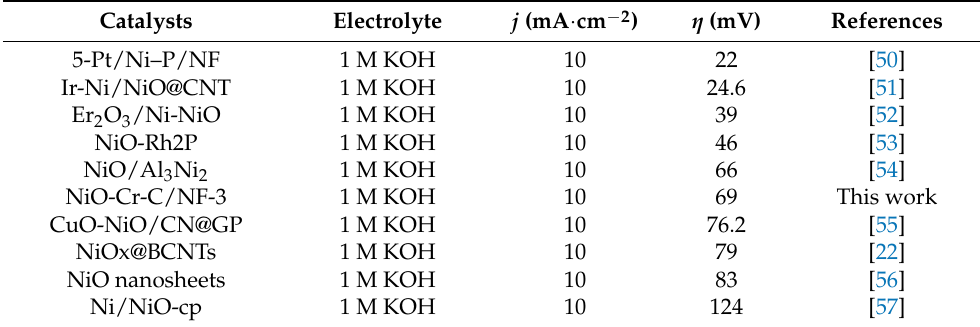
Table 1. Comparison of electrocatalytic performance for various noble metal electrocatalysts and NiO-based electrocatalysts for HER at 10 mA · cm − 2